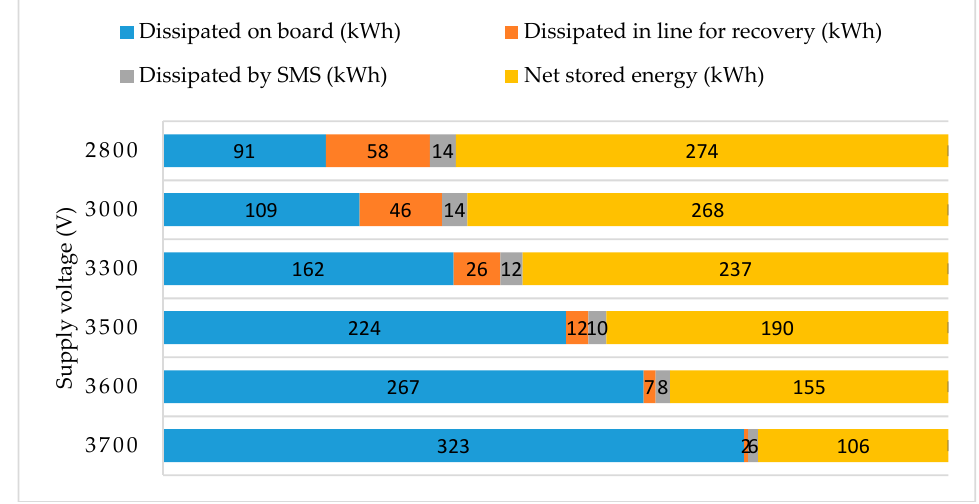
Figure 6. Energy analysis with a stationary ESS in Forlì on varying the supply line voltage.